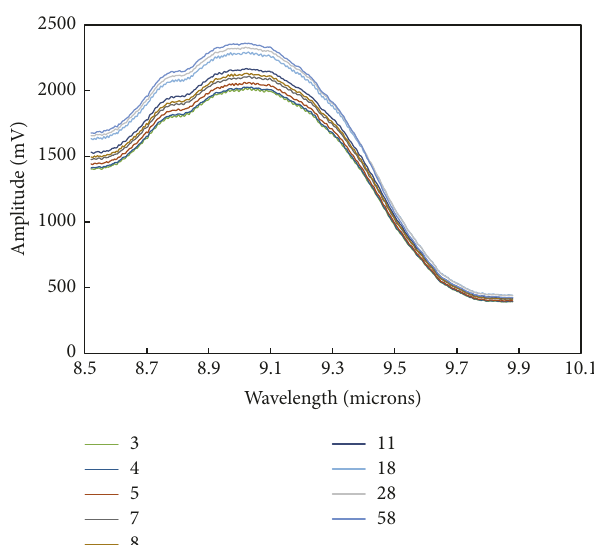
Figure 6: ATR-QCL raw data, signal amplitude (mV) in the absorption region of hydroxylamine nitrate centered at 8.95 𝜇 m, taken during the reaction of HAN 0.5M and HNO 3 2 M at 80 ∘ C. The legend refers to the reaction time in